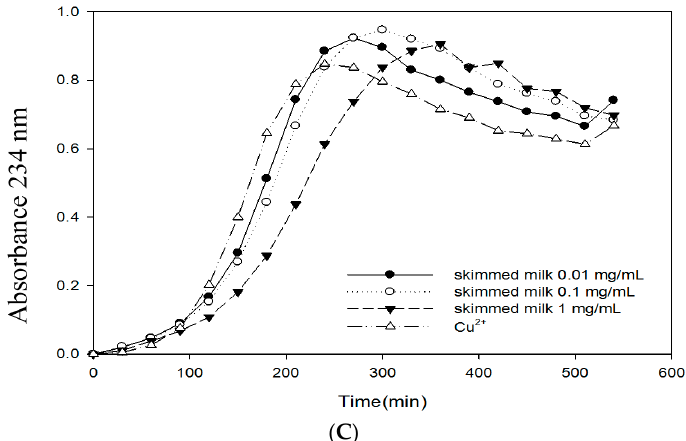
Figure 4. Effects of bovine colostrums protein on Cu 2+ mediated conjugated diene formation in LDL. LDL (100 μ g protein/mL) was incubated with 10 μ M CuSO 4 at 37 °C in the absence or presence of bovine colostrums protein. Conjugated diene was used to measure the absorbance at 234 nm every 30 min for 540 min and the results express relative absorbance at 234 nm. ( A ): Whey; ( B ): Cassin and ( C ): Skimmed milk.